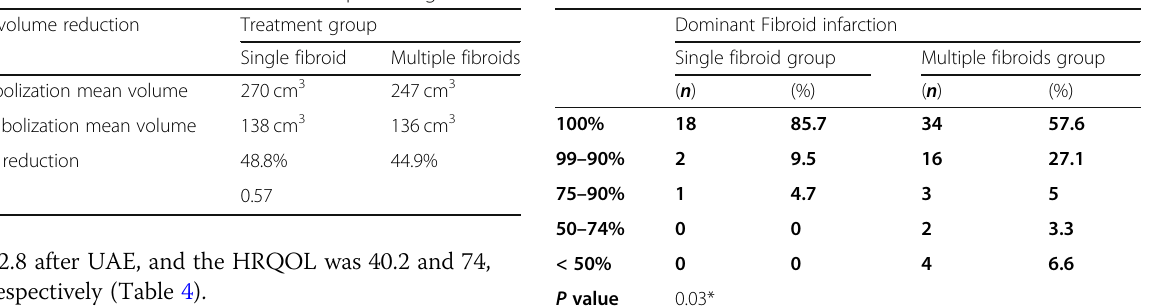
Table 5 Dominant Fibroid